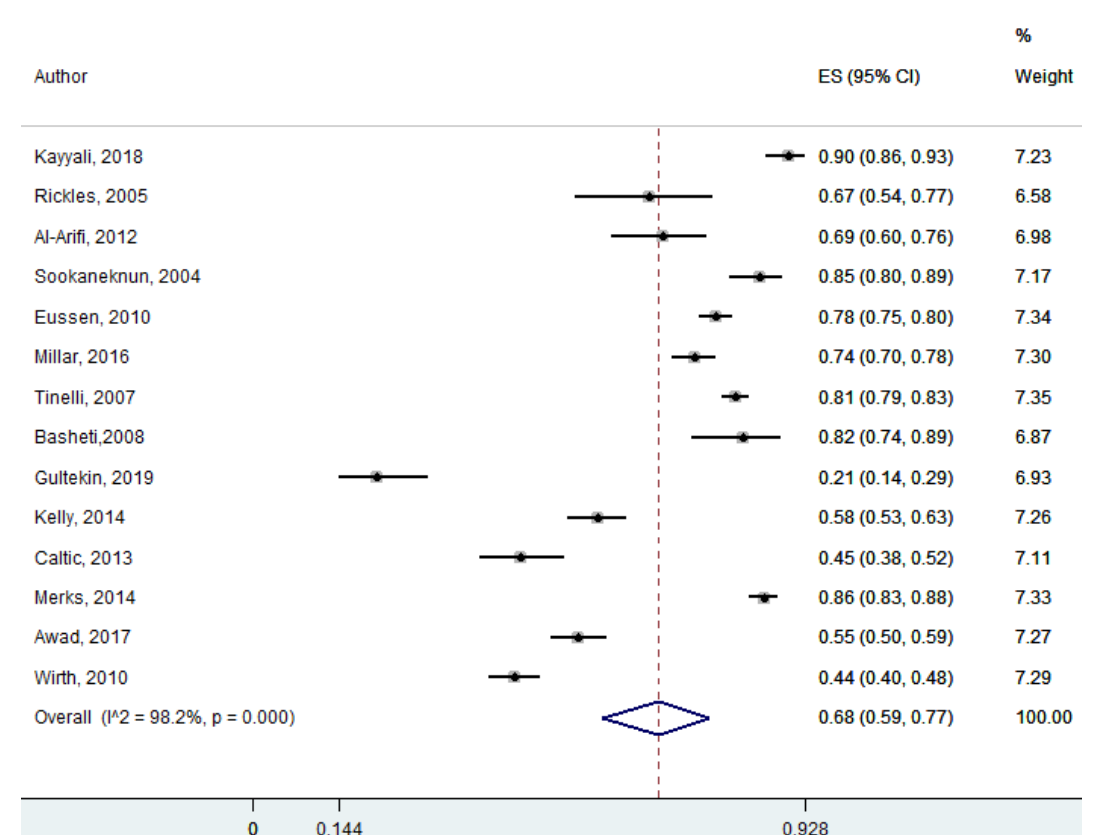
Figure 3. Importance of pharmacists’ intervention on medication adherence and quality use of medicine (14 studies).